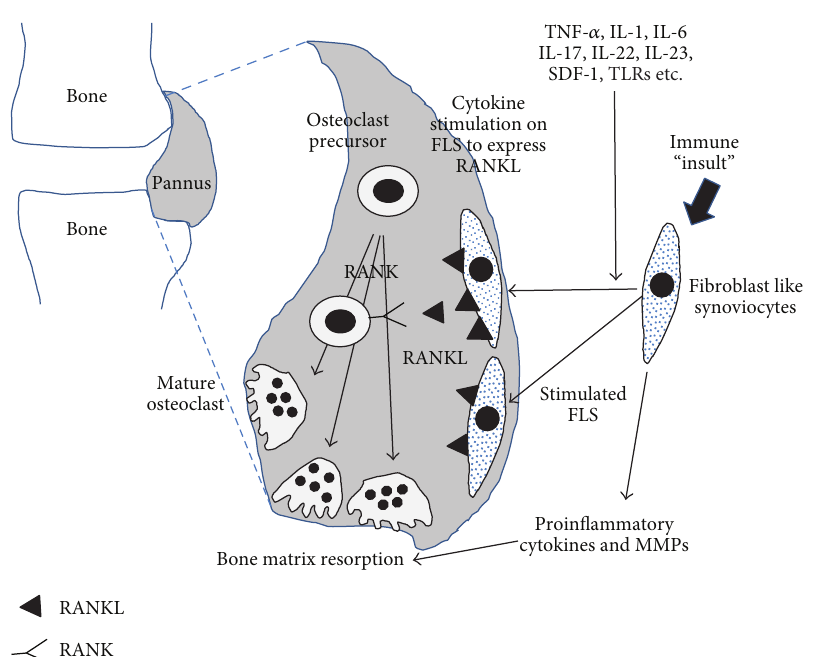
Figure 4: FLS could express RANKL in response to various stimuli. FLS-expressed RANKL enhances osteoclastogenesis and results in bone erosion in RA. Inflammatory and immune stimulation induce the FLS to produce proinflammatory cytokines and matrix metalloproteinase. These cytokines and enzymes aid osteoclasts to destroy the bone matrix.